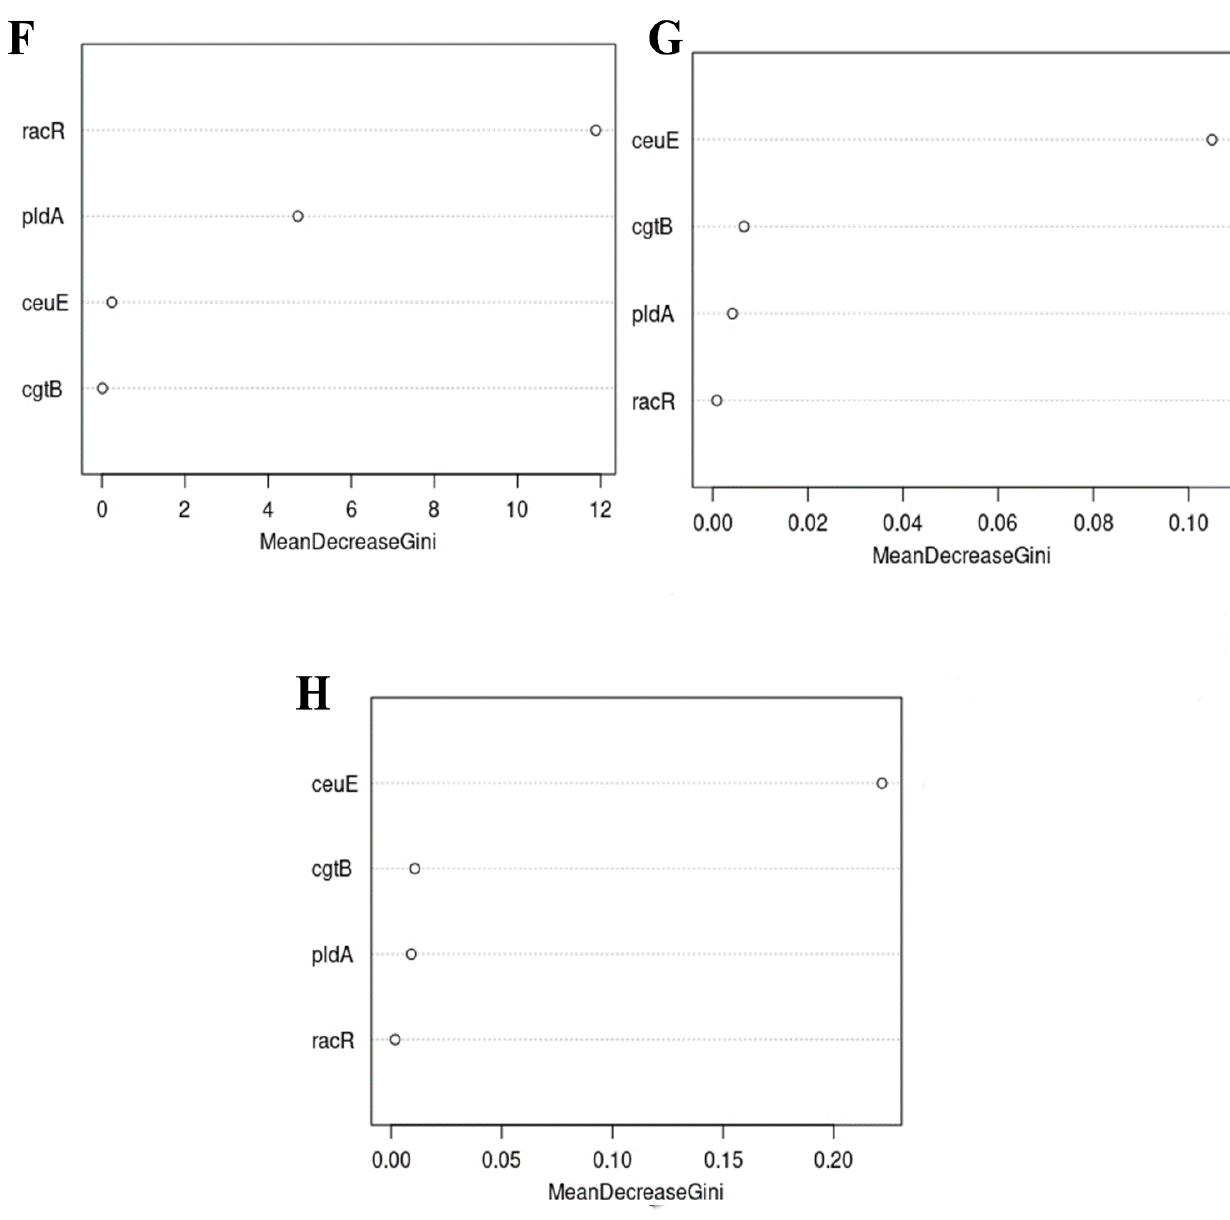
Figure 5. Random Forest analysis displaying the relationship between virulence genes and resis- tance status for each antibiotic ( n = 177). Plots display the predominant genes determining the resistance phenotypes through the MeanDecreaseGini value. Prediction of predominant virulence genes for all isolates that have a resistance to a specific antibiotic was observed as follows: ( A ) Amoxicillin, ( B ) Ampicillin, ( C ) Nalidixic Acid, ( D ) Ciprofloxacin, ( E ) Erythromycin, ( F ) Tetracycline, ( G ) Chloramphenicol, ( H ) Gentamicin.